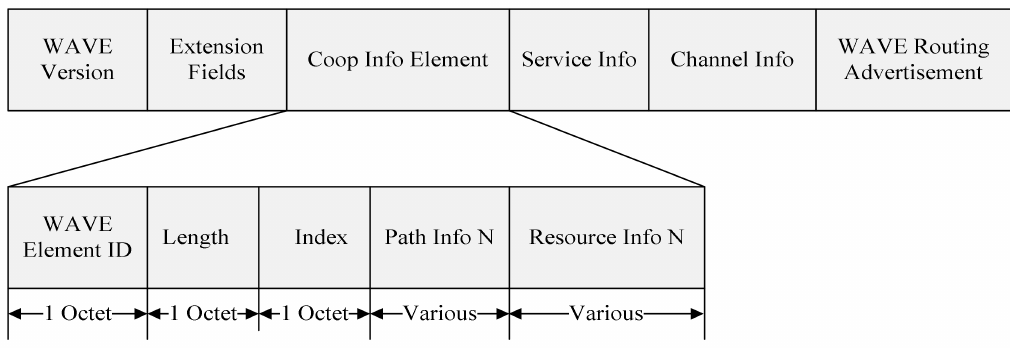
Figure 5. The format of the proposed WSA message.